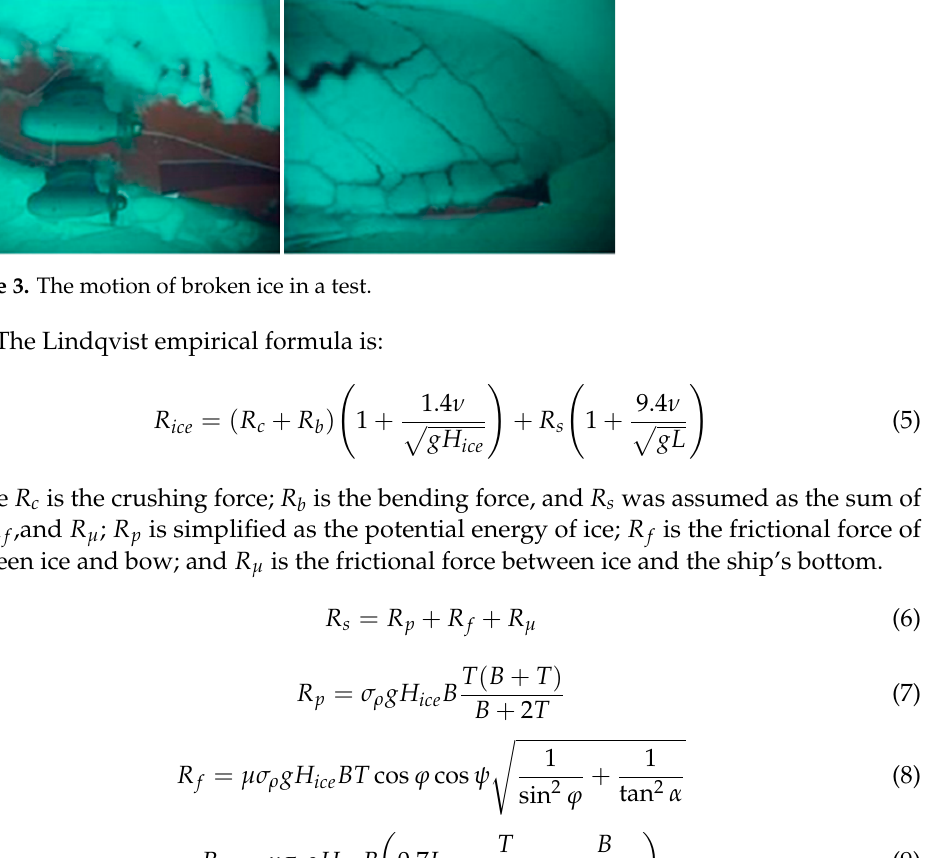
Figure 2. The solution process of ship–ice interaction.